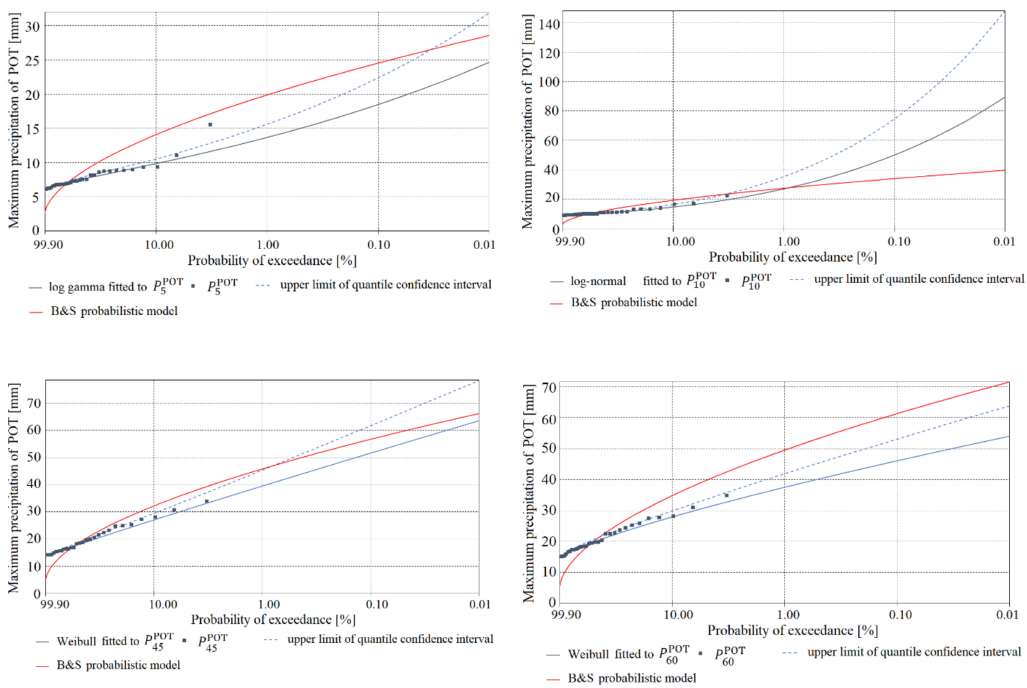
Figure 8. Plots of functions of probability of exceedance for the random variables P POT τ where τ = {5, 10, 45, 60} min, for the most credible probability distributions, with indication of upper limits of quantile confidence intervals according to the PMAXTP method, compared with the model of Bogdanowicz and Stach ý , for the Bialystok meteorological